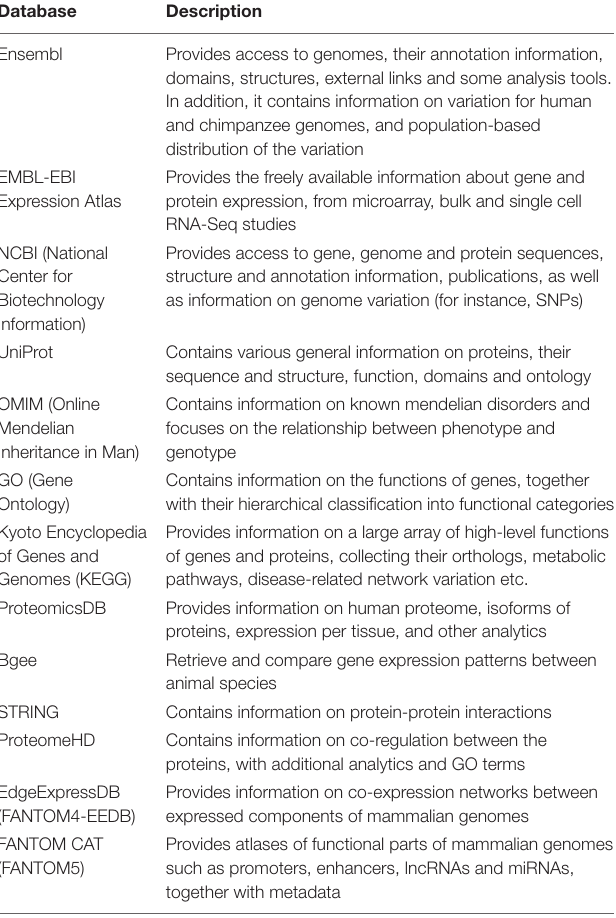
TABLE 1 | List of mined databases with the description of stored information and covered